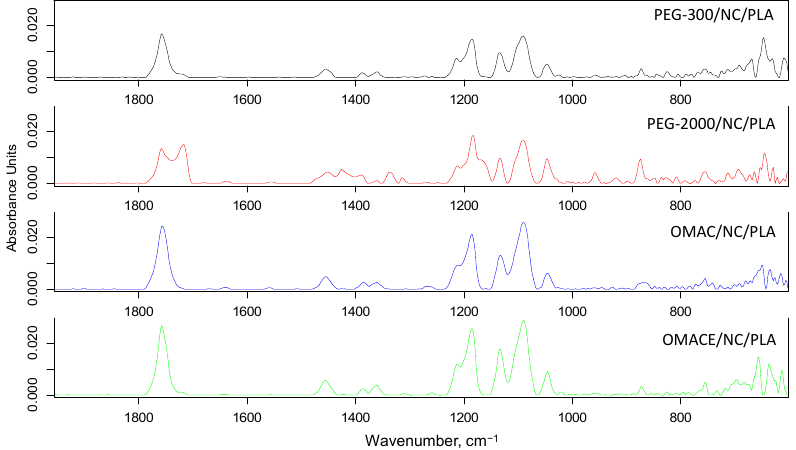
Figure 3. The FTIR spectra of specimens (PEG-300/NC/PLA, PEG-2000/NC/PLA, OMAC/NC/PLA, OMACE/NC/PLA).